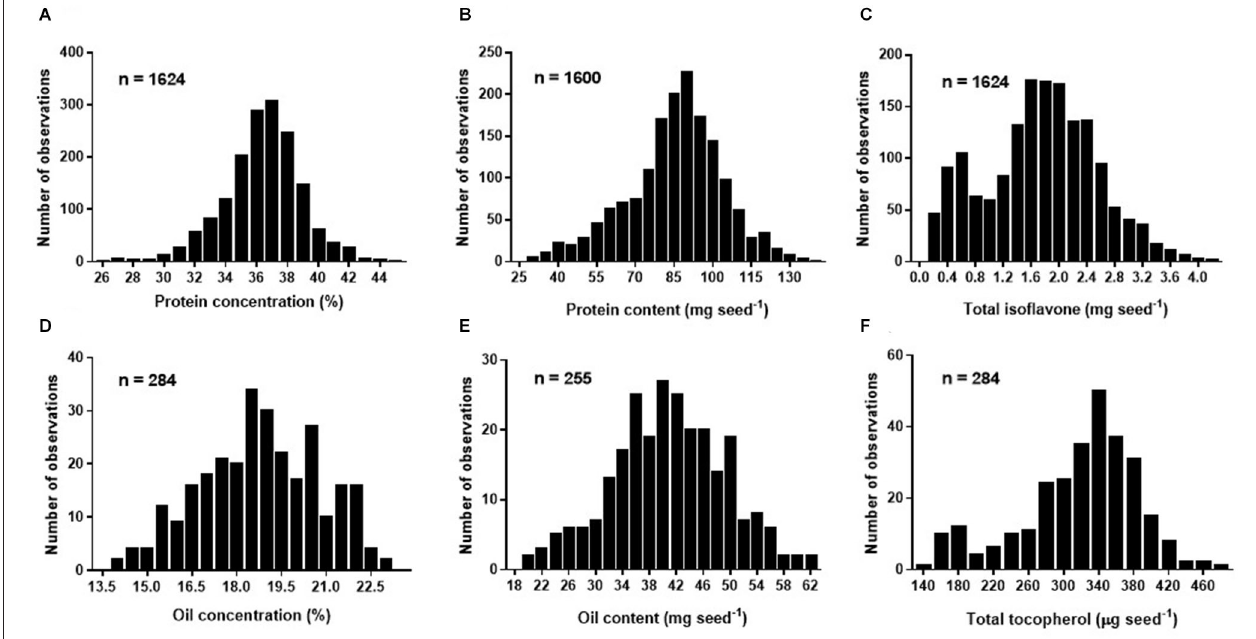
FIGURE 1 | Frequency histogram for soybean seed protein concentration (%) adjusted to 13% moisture (A) , protein content expressed in mg seed − 1 (B) , total isoflavone content expressed in mg seed − 1 (C) of Database 1, and oil concentration (%) adjusted to 13% moisture (D) , oil content expressed in mg seed − 1 (E) , and total tocopherol content expressed in µ g seed − 1 (F) of Database